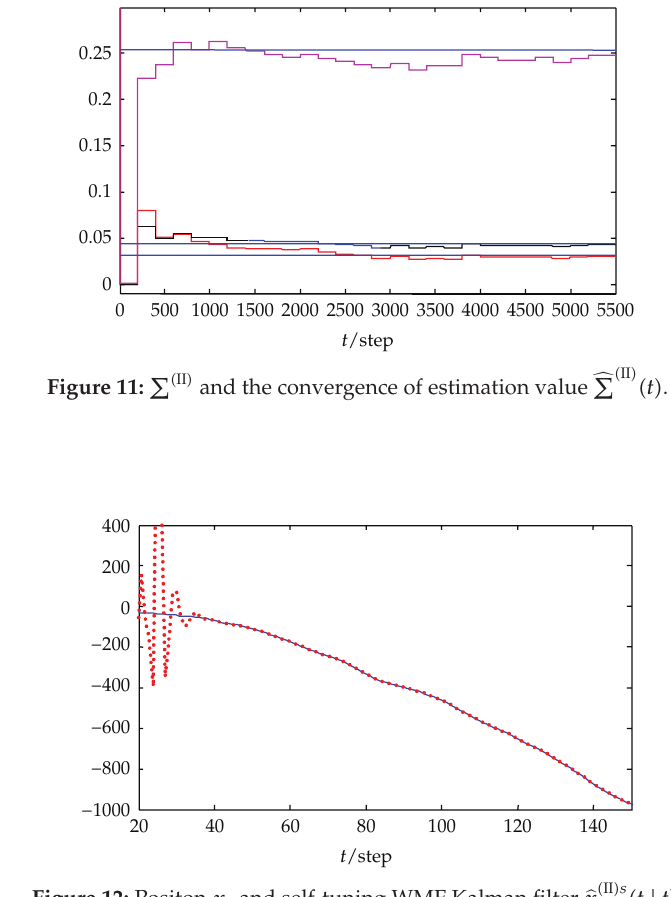
and the convergence of estimation value 2